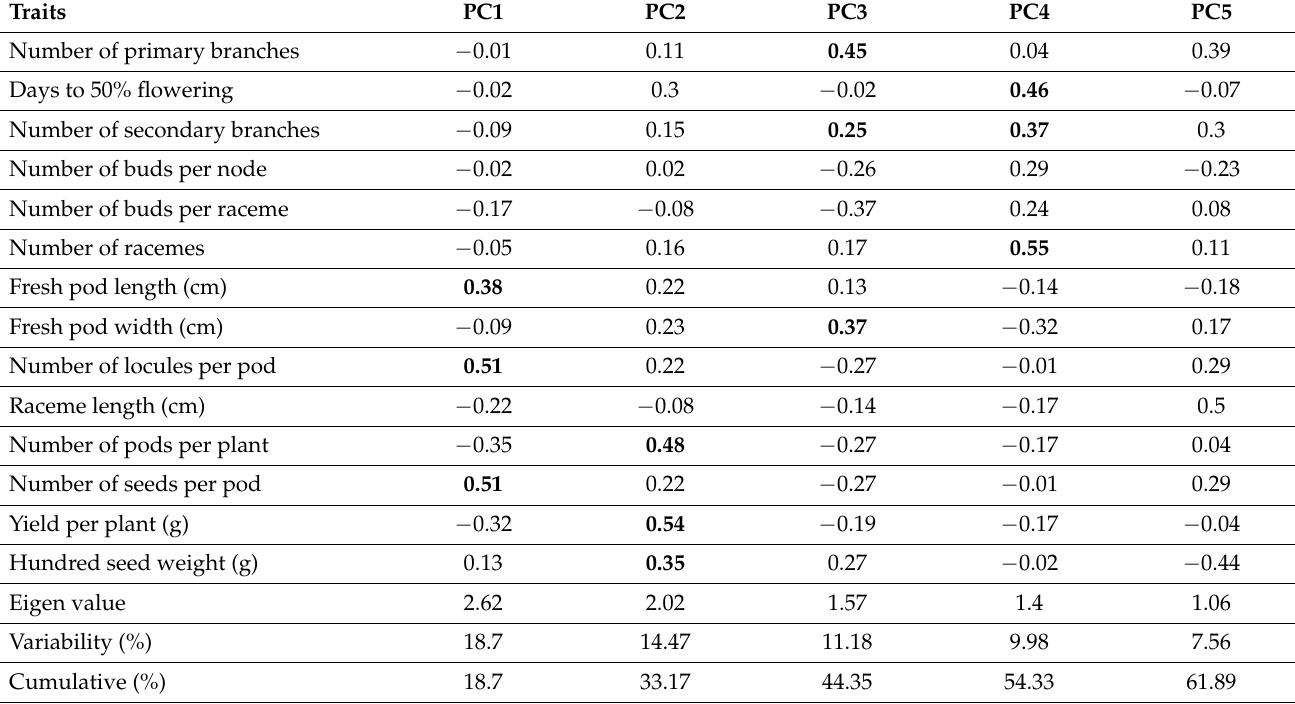
Table 4. Eigen values, proportion variability and quantitative traits that accounted for the first five principal components of lablab